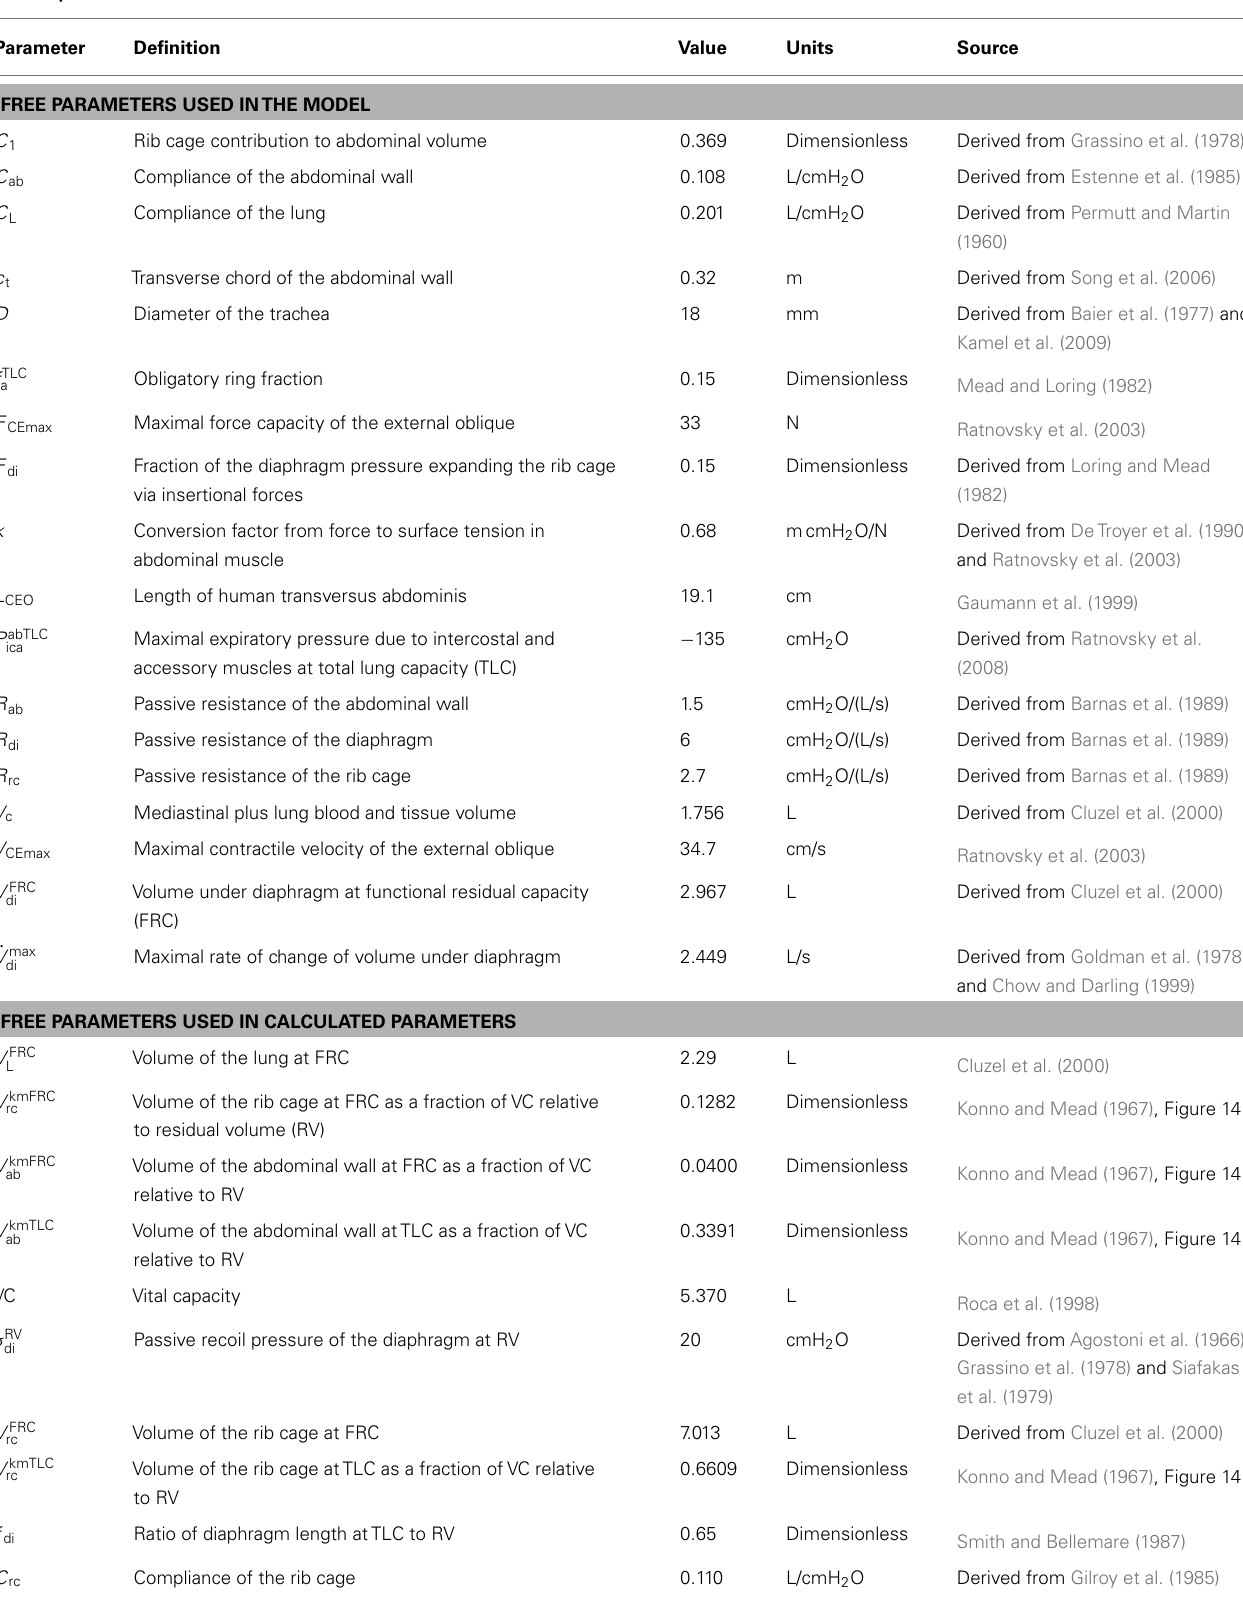
Table 1 | Parameters used in the biomechanical